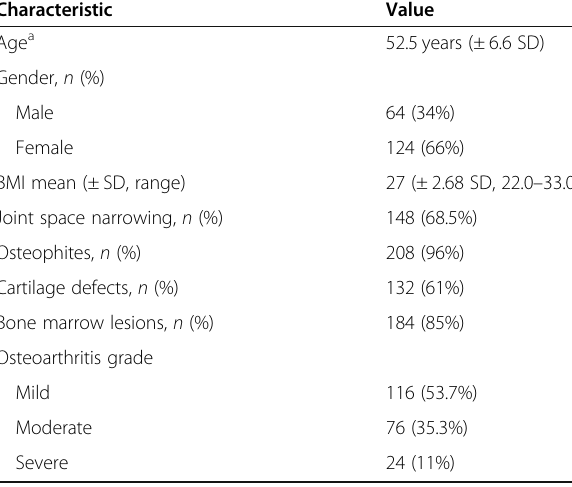
Table 2 Patients ’ characteristics for the 216 scans included in the study